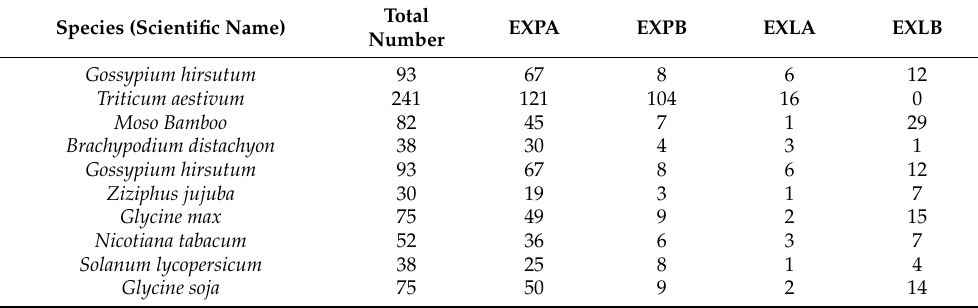
Table 1. Number of members in each subfamily of expansin in ten plant